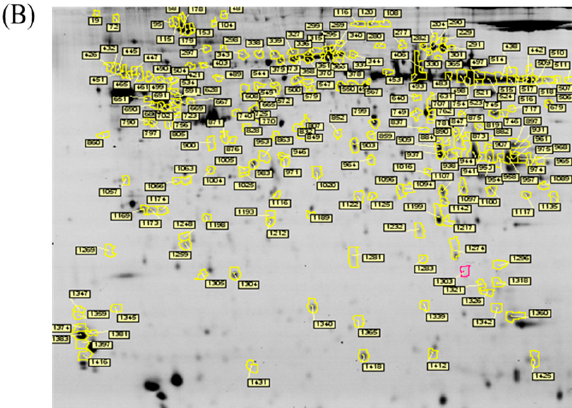
Figure 1. Comparison of proteomics between the ischemia–reperfusion (IR) injury and control groups (Ctrl) in cornea. MW: molecular weight ( A ) Schematic representation of the two-dimensional difference gel electrophoresis (2D-DIGE) workflow for monitoring the differentially expressed proteins in the cornea of the IR injury and control groups, and Cy2 pool represents the total protein spots; ( B ) 2D-DIGE images of the tissue samples analyzed using DeCyder software; the differentially expressed identified protein features are annotated with circles and spot numbers.